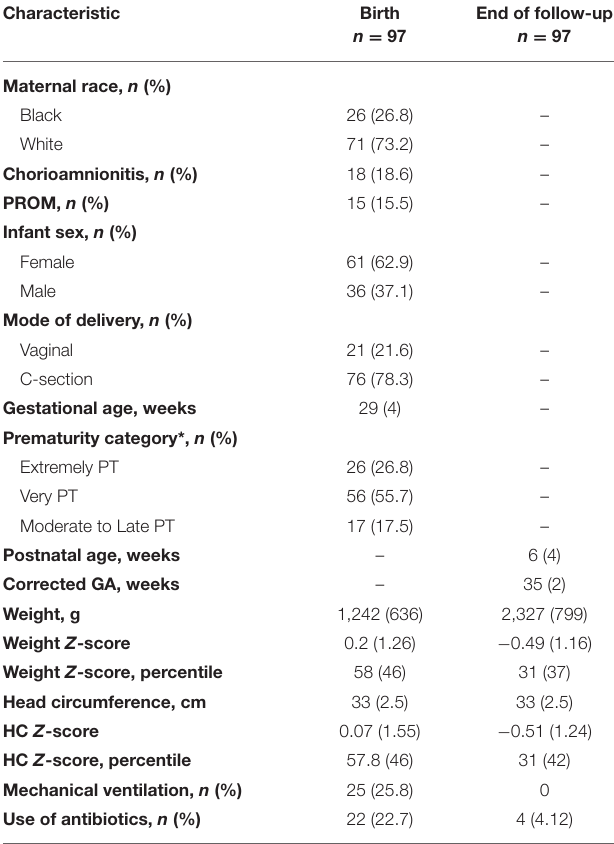
TABLE 1 | Characteristics of study